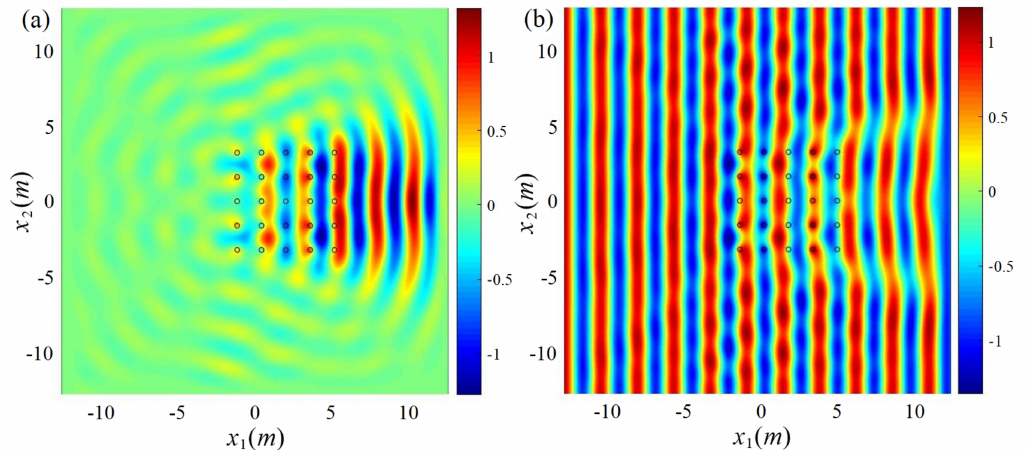
Figure 11. Calculated wave field for a WEC array in constant depth h = 0.7 m, modelled by 25 in- clusions in a 5 × 5 arrangement obtained by the present MMSE (with β = 0.1, α = 2), for harmonic incident waves of period T = 1.26 s. ( a ) Real part of the scattering field. ( b ) Real part of the total